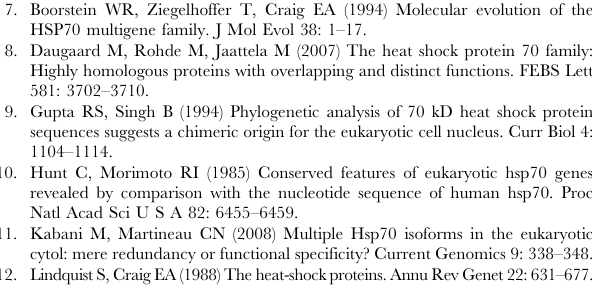
Figure S2 CFTR degradation monitored by cycloheximide- chase. Representative gels for the quantifications shown in Figure 11 (see Material and Methods for details). Immunoblots against the endoplasmic reticulum protein BiP were used as loading controls. Figure S3 Steady-state protein levels in strains expressing individual Ssaps. Total protein extracts were prepared from the indicated strains as described in figure 11 legend (without the addition of cycloheximide). Equal amounts of proteins were analyzed by SDS-PAGE and immunoblotting with antibodies against the indicated proteins. Table S1 Oligonucleotides used in this